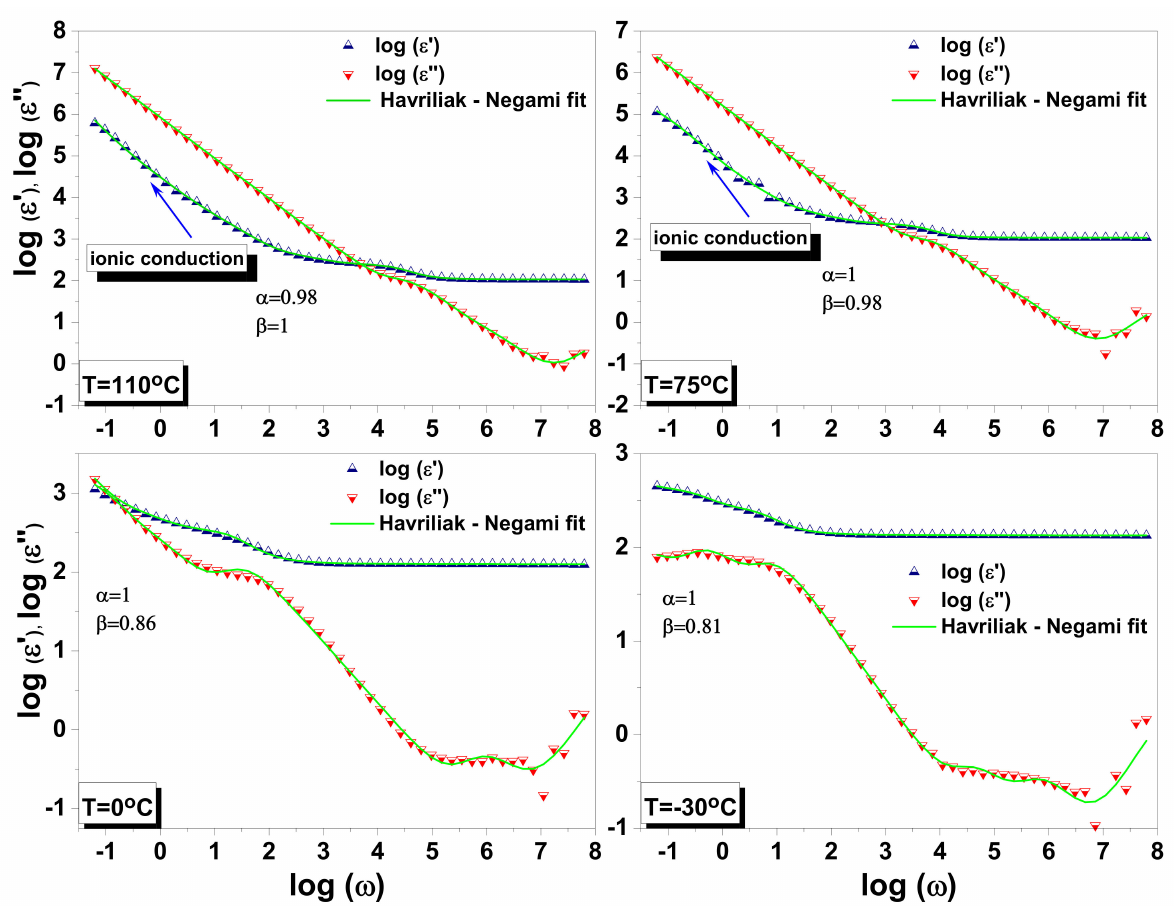
Figure 9. Complex permittivity components ε (cid:48) ( ω ) and ε (cid:48)(cid:48) ( ω ) as a function of angular velocity ( ω = 2 πν ) illustrated for a few selected